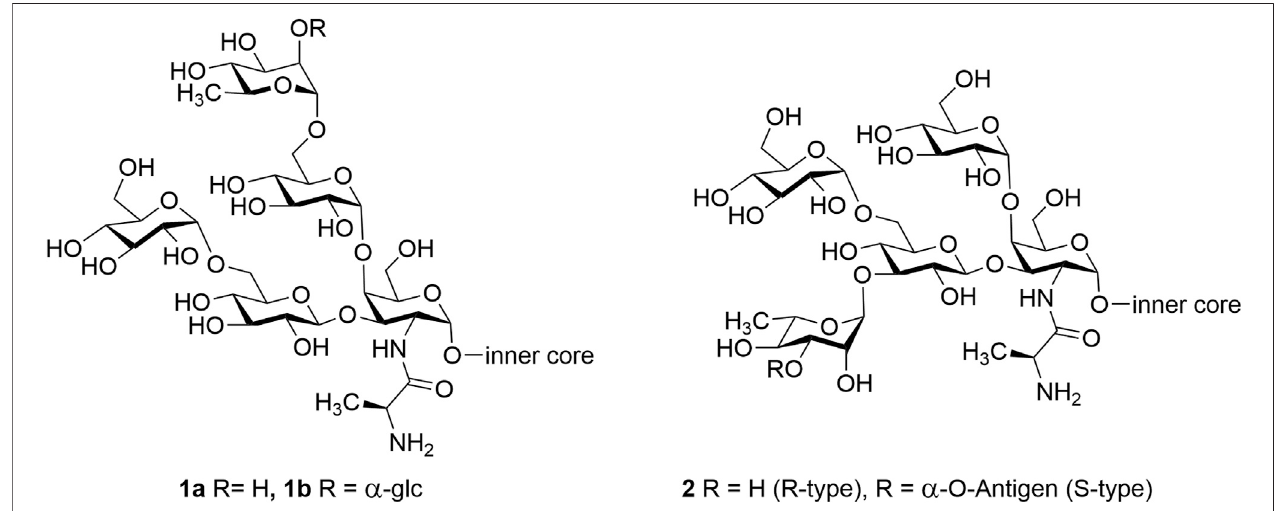
FIGURE 1 | P. aeruginosa LPS outer core structure of glycoform I ( 1a,b ) and glycoform II ( 2